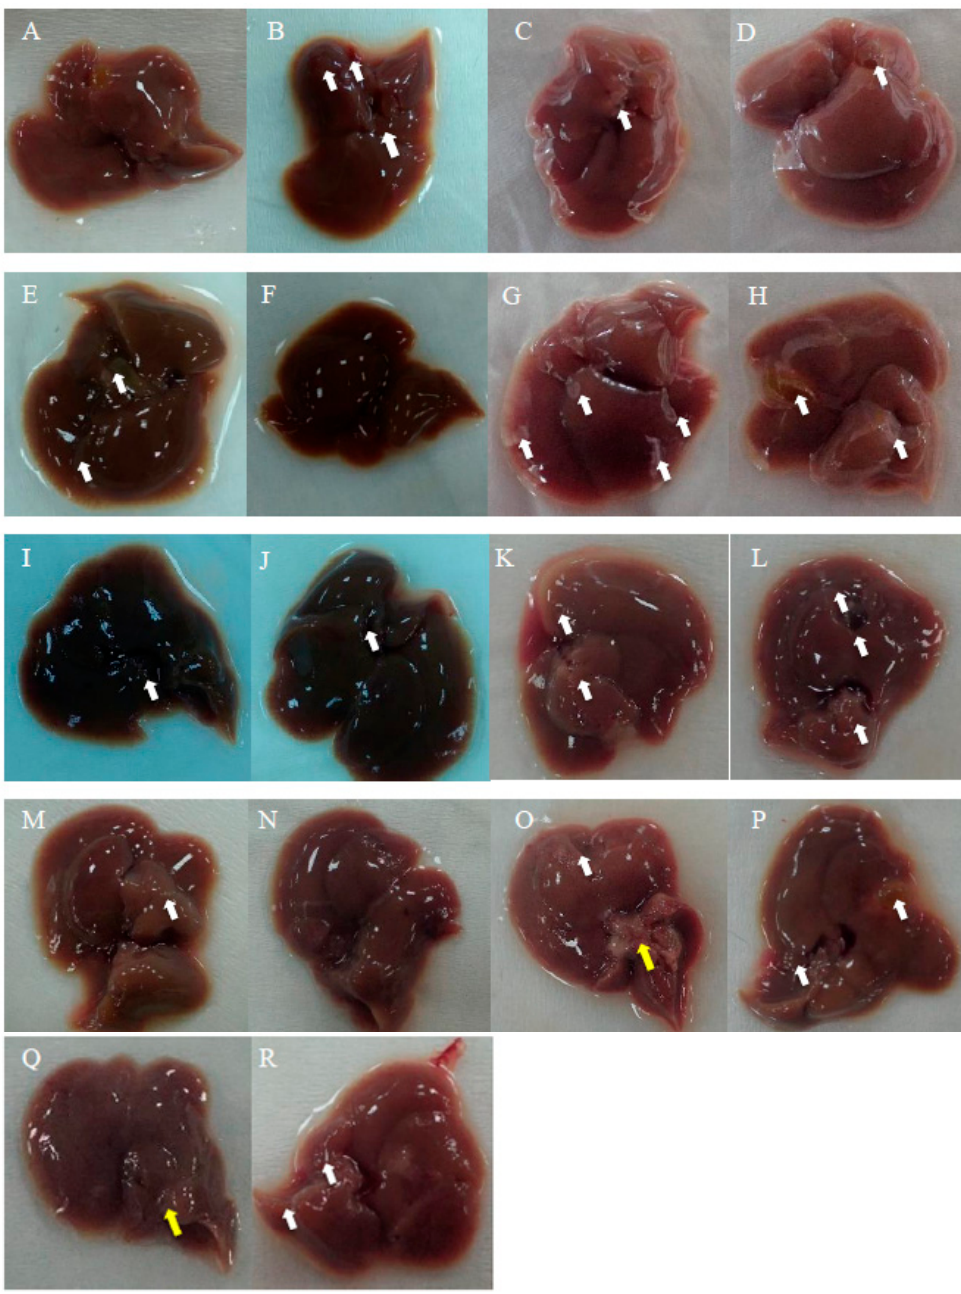
Figure 5. Gross observations of the liver in mice with or without treatment with Asta-lipo or pure liposomes for 2 and 4 weeks on the mouse model that received two modes of alcohol